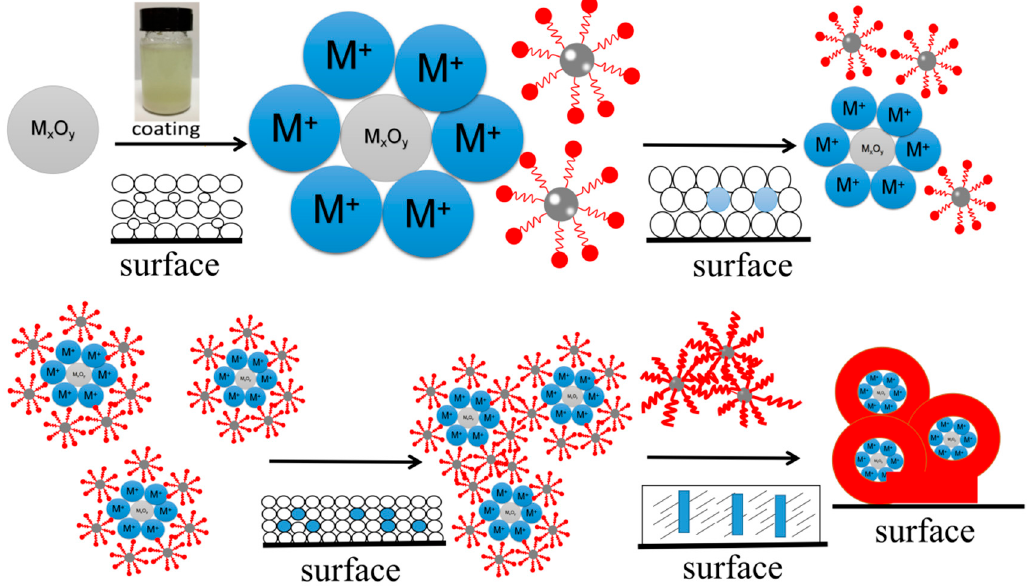
Figure 8. The activity of the decontaminant on soluble nuclide compounds.